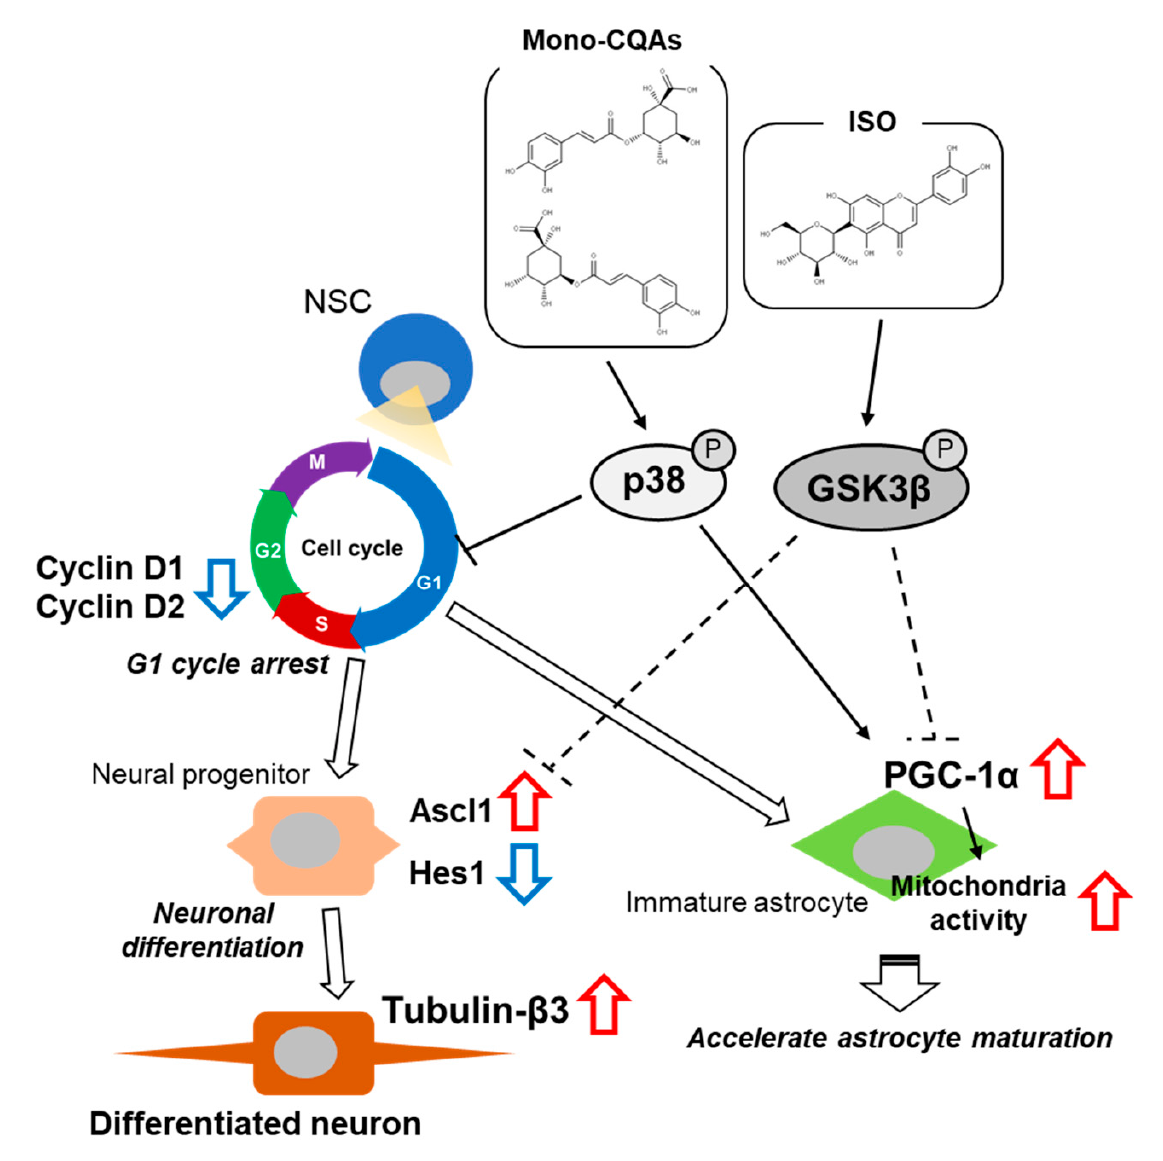
Figure 6. Schematic diagram of the effect of STEE’s major polyphenolic constituents on hNSCs neuronal differentiation and immature astrocyte mitochondrial activity. CQAs triggers p38 activation and induce G1 cycle arrest of NSCs, thus increasing the potential for cell differentiation. In turn, ISO favors neuronal cell fate decisions by inactivating GSK3 β and inducing a regulation of transcription factors (upregulation of Ascl1 and downregulation of Hes1 ). These effects synergistically cause neuronal differentiation. Activation of p38 and inactivation of GSK3 β also promote PGC-1 α expression in immature astrocytes. p38: p38 mitogen-activated protein kinase; GSK3 β : glycogen synthase kinase 3 β ; Ascl1: achaete-scute homolog 1; Hes1: hairy and enhancer of split 1; PGC-1 α : peroxisome proliferators-activated receptor- γ co-activator-1 α .